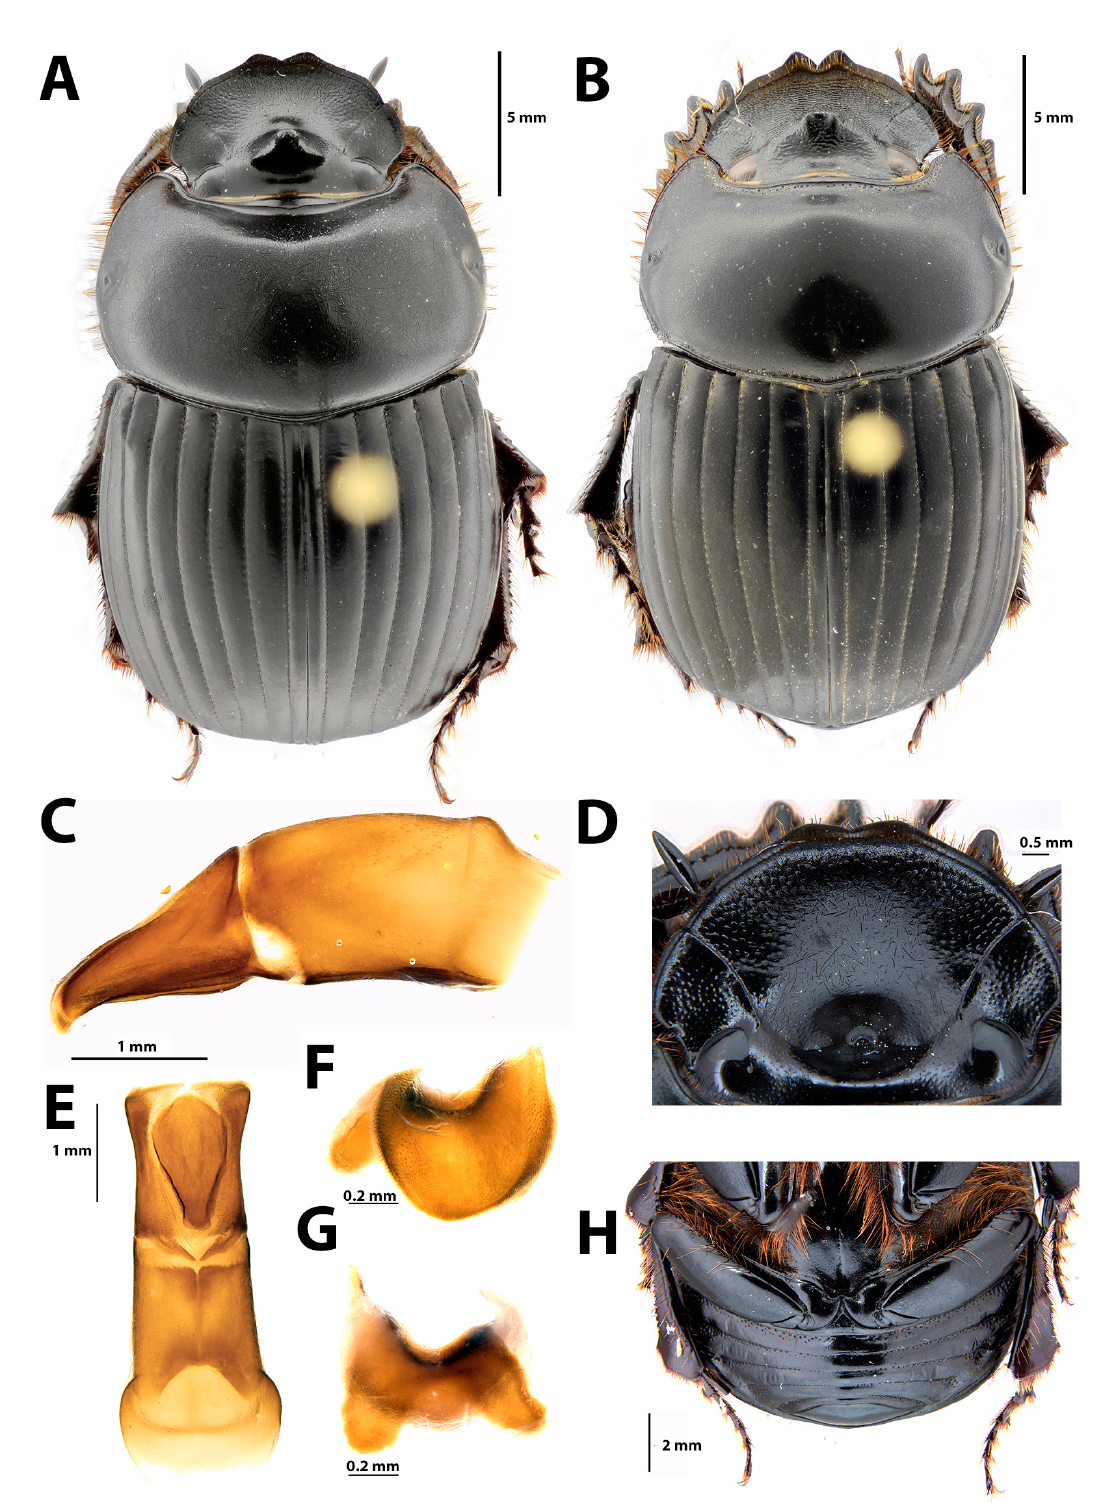
Fig. 18. Dichotomius validipilosus (Luederwaldt, 1931). A–B . Dorsal habitus. A . ♂. B . ♀. C . Lateral view of the aedeagus. D . View from above of the head, basal third surface subrugose. E . Ventral view of the aedeagus. F–G . Lamella copulatrix. H . Punctures along the anterior margin of the punctuated, sixth sternite marginally lower,